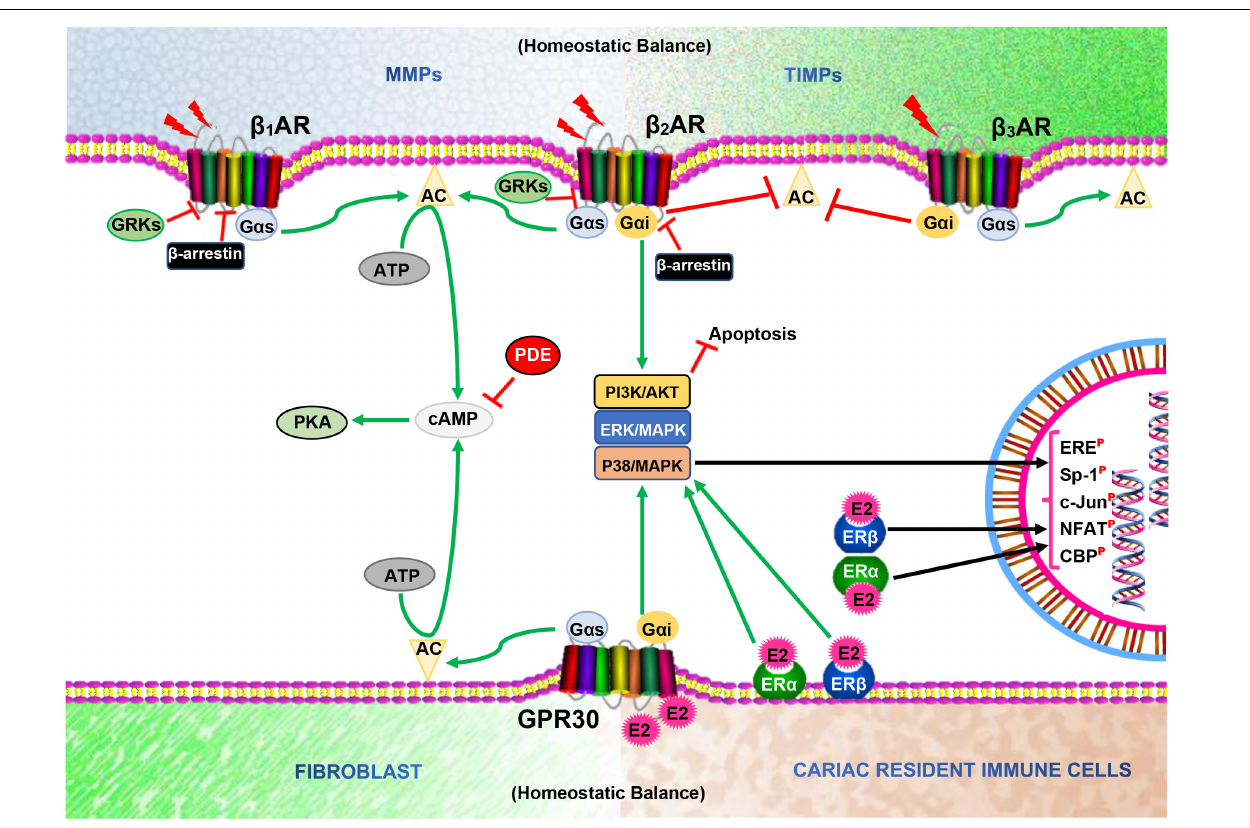
FIGURE 1 | Illustration of homeostatic state between MMPs and TIMPs, and Fibroblast and Cardiac resident immune cells as well as β -adrenergic receptors ( β ARs) and Estrogen receptors (ERs) signaling interplays in the cardiomyocytes. AC, Adenylyl cyclase; cAMP, Cyclic adenosine monophosphate; PKA, Protein kinase A; GRKs, G protein-coupled receptor kinases; E2, Estrogen; PDE, Phosphodiesterase; ERE, Estrogen receptor element; Sp-1, Stimulating protein-1; NFAT, Nuclear factor of activated T cells; , Phosphorylated; , Inhibit; ,